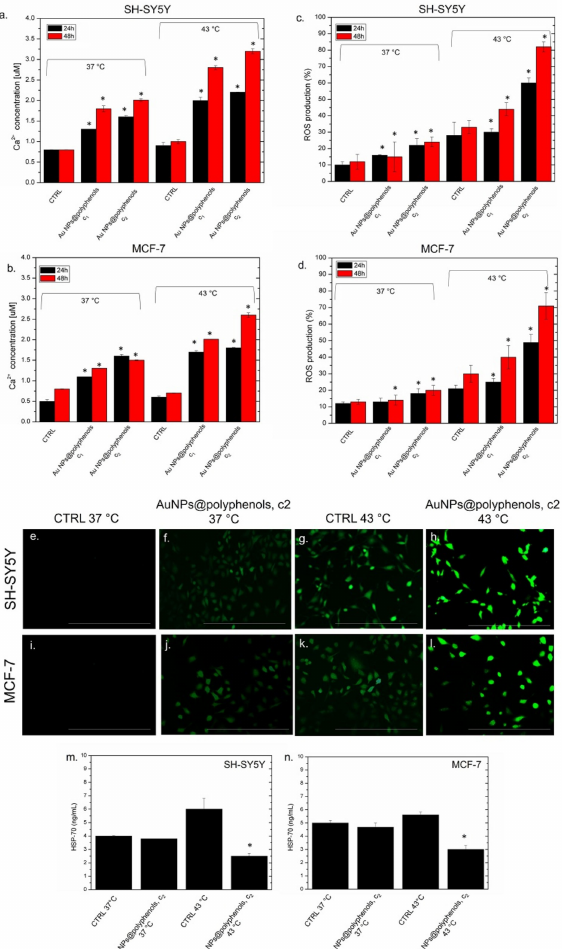
Figure 8. Effect of Au NPs@polyphenols on the Ca 2+ level in SH-SY5Y ( a ) and MCF-7 ( b ) cells after 24 h and 48 h of exposure to two doses (c1 and c2) of Au NPs@polyphenols at 37 ◦ C and 43 ◦ C, following the procedure described in the section, Materials. The data are reported as the mean ± SD from three independent experiments; * p < 0.05, compared with control ( n = 8). ( c , d ) The effect of Au NPs@polyphenols on the ROS level in SH-SY5Y and MCF-7 cells after 24 h and 48 h of exposure to two doses (c1 and c2) of Au NPs@polyphenols at 37 ◦ C and 43 ◦ C, following the procedure described in the section, Materials. The ROS generation of NP-treated cells is expressed relative to non-treated control cells. As a positive control (P), the cells were incubated with 500 µ M of H 2 O 2 , showing a ca. 300% DCFH-DA increase (not shown). The data are reported as the mean ± SD from three independent experimens; * p < 0.05, compared with the control ( n = 8). ( e – l ) Representative fluorescence images of SH-SY-5Y and MCF-7 cells exposed to the c2 of Au NPs@polyphenols at 37 ◦ C and 43 ◦ C, following the procedure described in the section, Materials. ( m ) ELISA quantitative analyses of HSP70 in SH-SY5Y and MCF-7 cells treated with Au NPs@polyphenols at 37 ◦ C and 43 ◦ C at the c2 concentration, following the procedure described in the section, Materials. Histogram showing the levels of HSP70 expressed in ng/mL in SH-SY5Y ( n ) and MCF-7. The data are presented as the mean ± standard deviation of three independent experiments: * p <